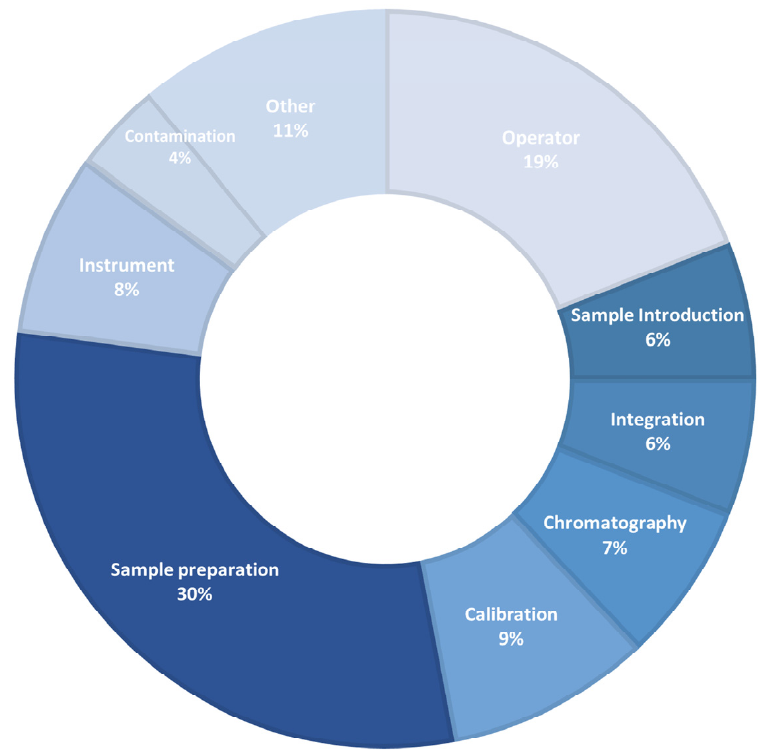
Figure 1. Sources of error generated during chromatographic analysis.